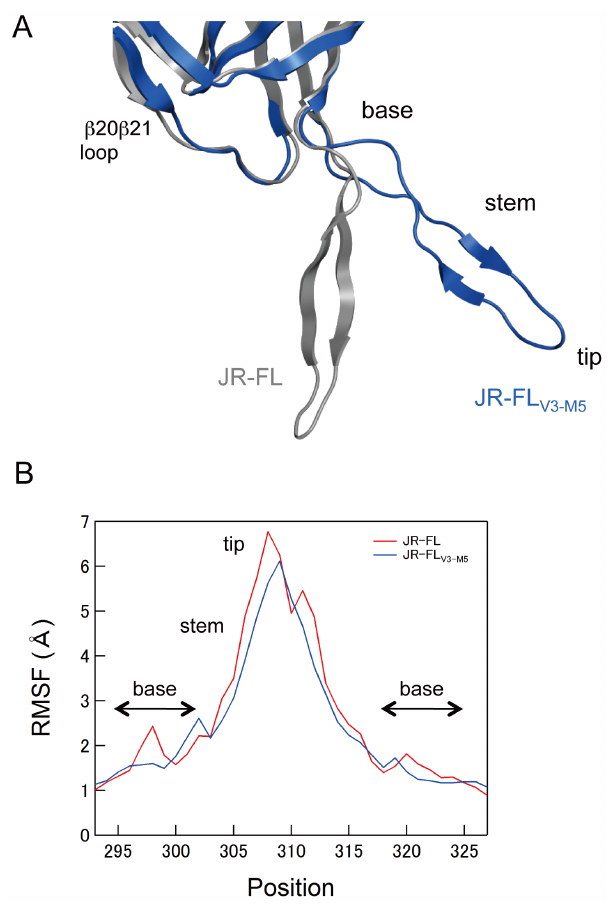
Figure 7. MD simulation of the HIV-1 gp120 outer domain. (A) Superimposition of averaged structures obtained from 40,000 snap- shots during the 10–20 ns of MD simulation. Grey and blue ribbons indicate the gp120 V3 of JR-FL an and JR-FL V3-M5 , respectively. (B) Distribution of RMSF in the V3 region of gp120. The RMSF values indicate the atomic fluctuations of the main chains of individual amino acids during the 10–20 ns of MD simulations.